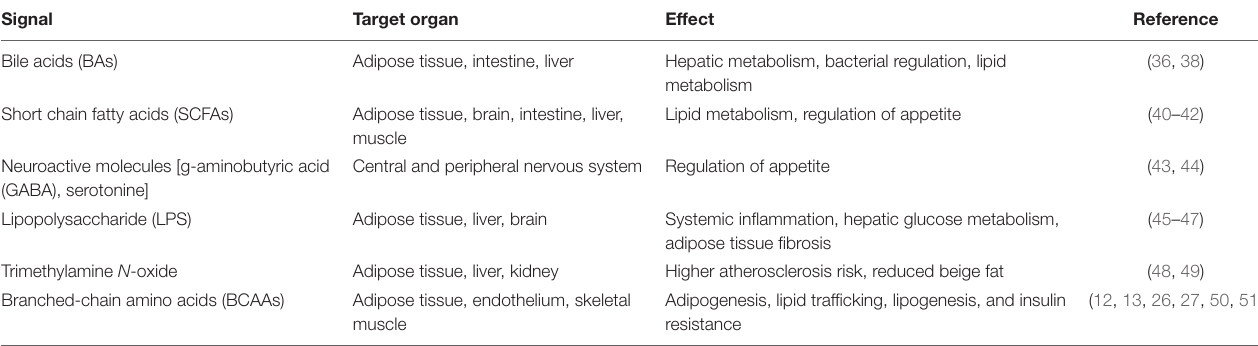
TABLe 1 | List of microbe-derived signals that can impact host